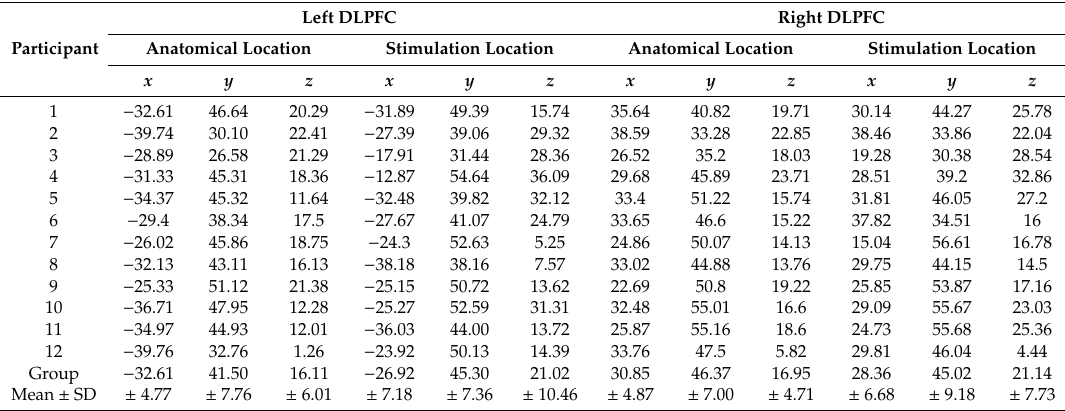
Table 1. Left and Right dorsolateral prefrontal cortex (DLPFC) anatomical and actual transcranial magnetic stimulation (TMS) stereotaxic neuronavigated locations based on Talairach coordinates ( x , y , z ) in mm based on Talairach Atlas.